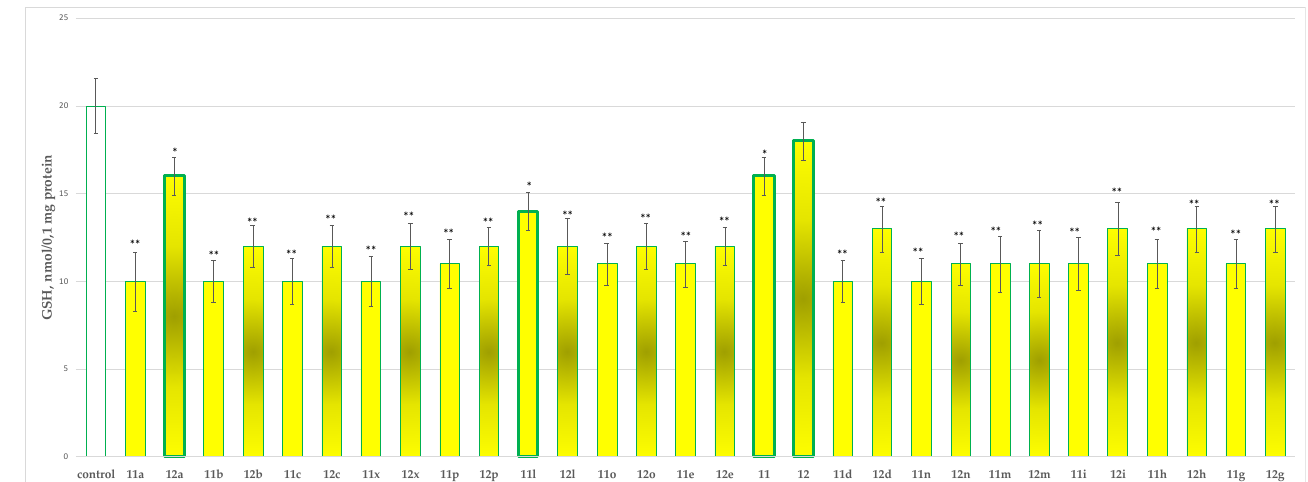
Figure 6. Effects of compounds 11 , 11a – 11x, 12 and 12a – 12x (100 μ mol), applied alone, on MDA production. *** p < 0.001 against the control (untreated mitochondria). The green outline indicates the most promising derivatives.